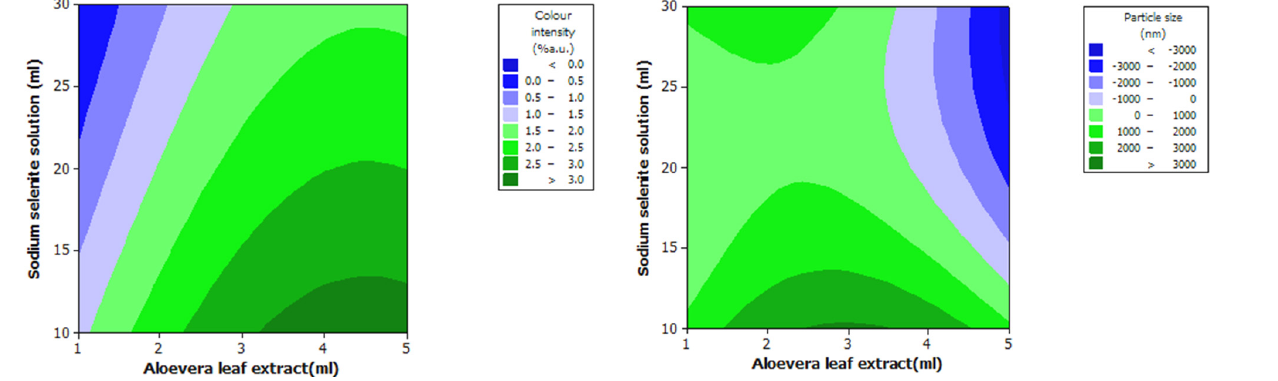
SeO solution and Aloe vera leaf 2 3